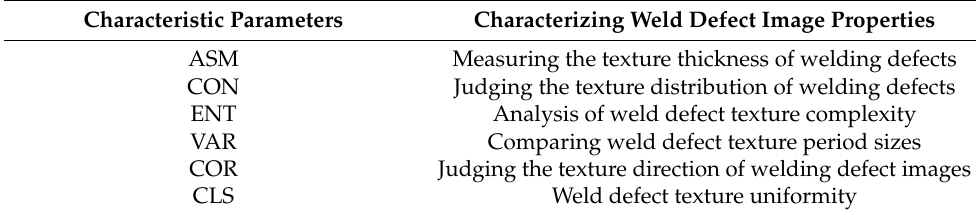
Table 3. Characteristic parameters and their characteristic defect